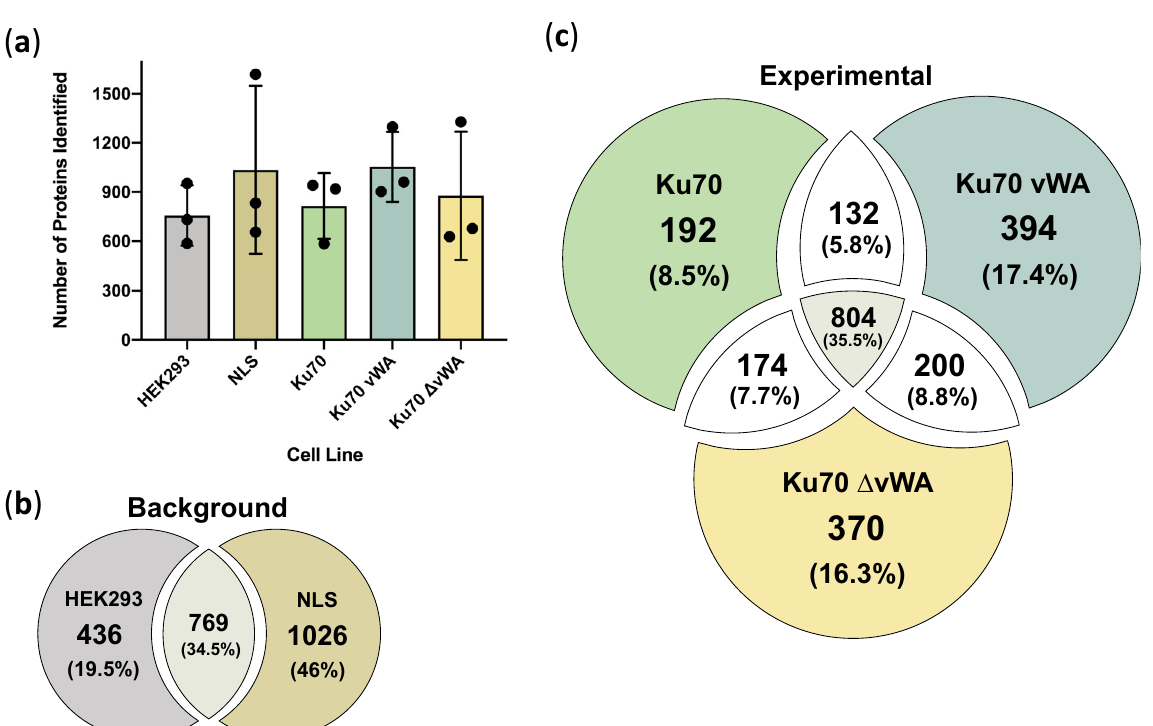
Figure 4. Comparing the total number of proteins identified by BioID2 using Liquid Chromatography-Electrospray Ionization-Tandem Mass Spectrometry (LC-ESI-MS/MS), where proteins were identified by having ≥ 1 unique peptide(s) and FDR was set to 1%; ( a ) Total number of proteins in three biological replicates of BioID2 in HEK293 stable cell lines: parental HEK293, NLS (Ku70)-BioID2, Ku70-BioID2, Ku70 vWA-NLS-BioID2, and Ku70 ∆ vWA-BioID2. Each replicate is represented by a black dot; ( b ) Venn diagram of the total number of proteins for negative controls, HEK293 and NLS (Ku70)-BioID2. Any proteins that appeared at least once in the three biological replicates for each cell line are included; ( c ) Venn diagram of the total number of proteins identified for each experimental condition: full-length wild-type Ku70-BioID2, Ku70 vWA-NLS-BioID2, and Ku70 ∆ vWA-BioID2. Any proteins that appeared at least once in the three biological replicates for each cell line are included. Subsequently, only candidate proteins that appeared in three biological replicates were selected for the final candidate lists.